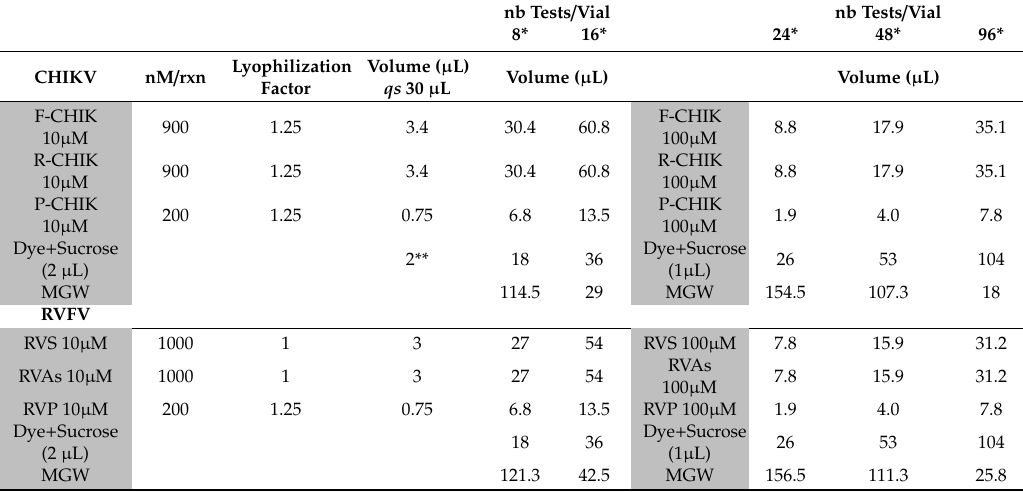
Table 2. Primers and Probe mix solutions.